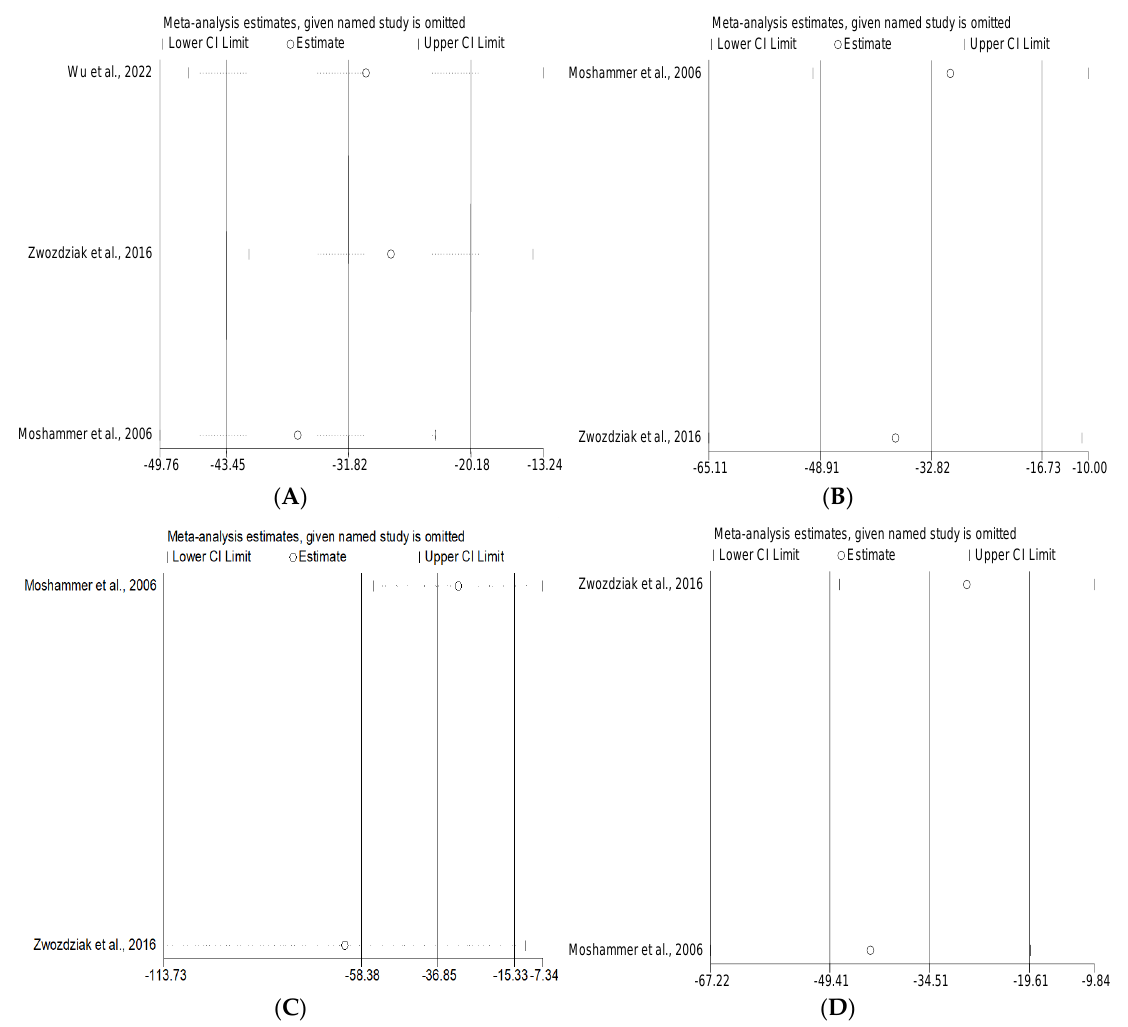
Figure 5. Funnel plot of the effects of PM 1 on lung function indicators in the long-term exposure group: ( A ) FVC, ( B ) FEV 1 , ( C ) PEF, ( D ) MMEF.